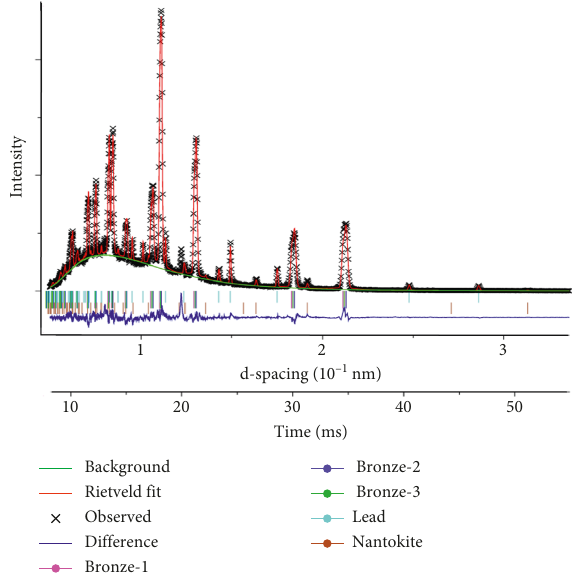
Figure 9: Rietveld refinement of the TOF-ND data for HG-2 with a slightly worse fit ( χ 2 � 5.1) than the average ( χ 2 � 4.6) for the coin Table 2: TOF-ND (bulk) and XRF (surface) element percentages.